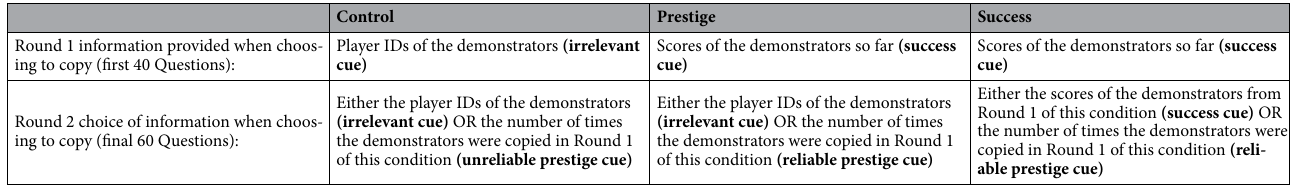
Table 1. Information available to participants when choosing to copy in each round and condition.